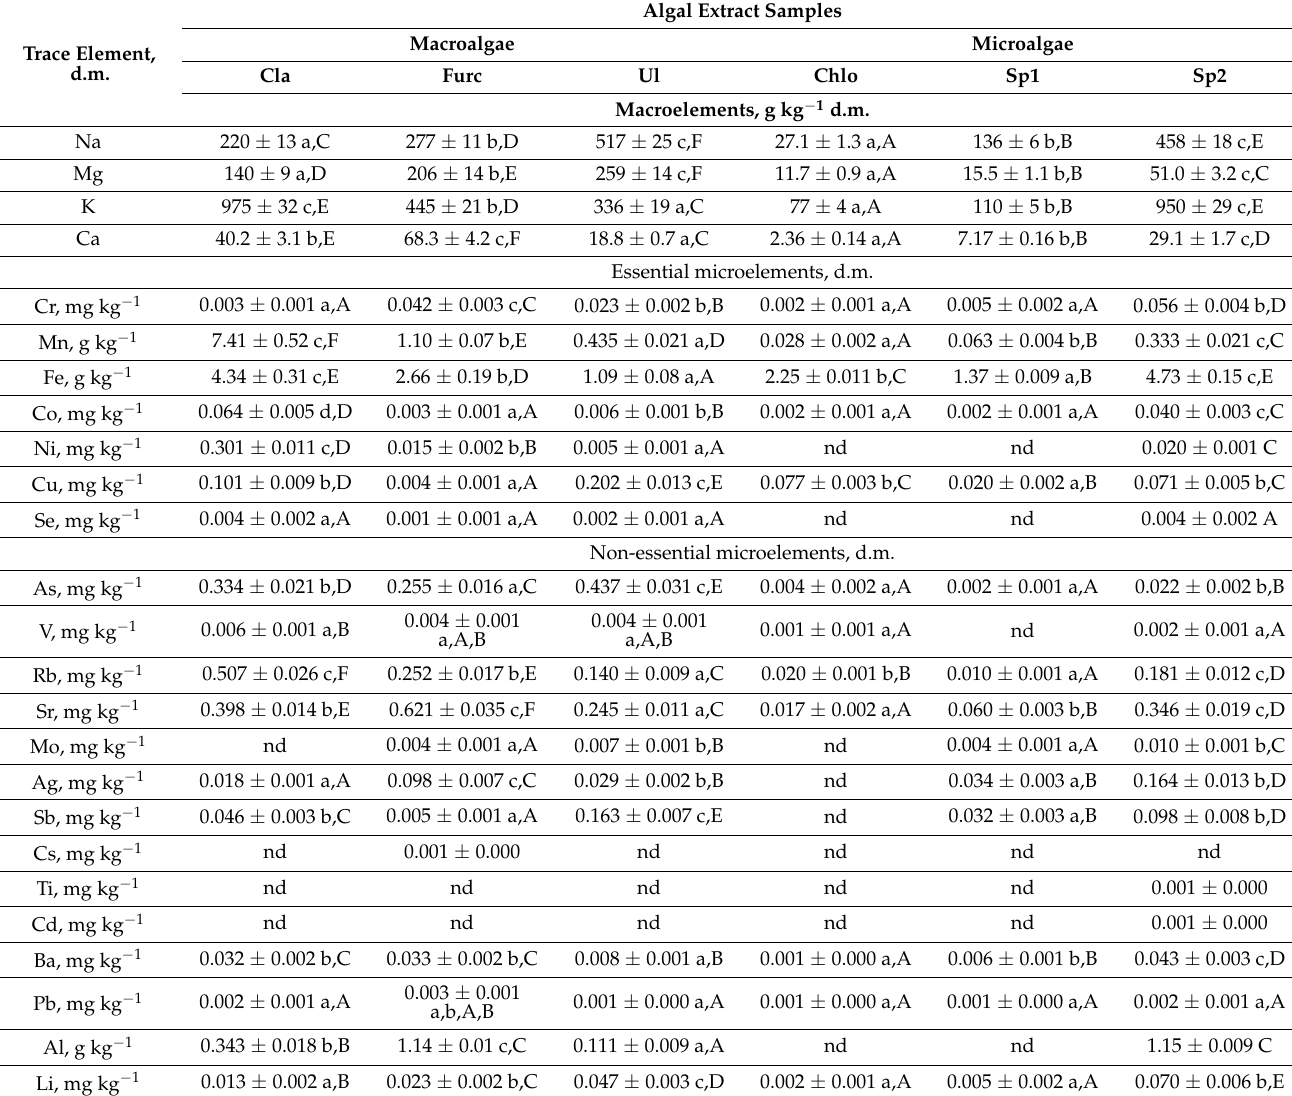
Table 3. Micro- and macroelement concentrations in algal extract